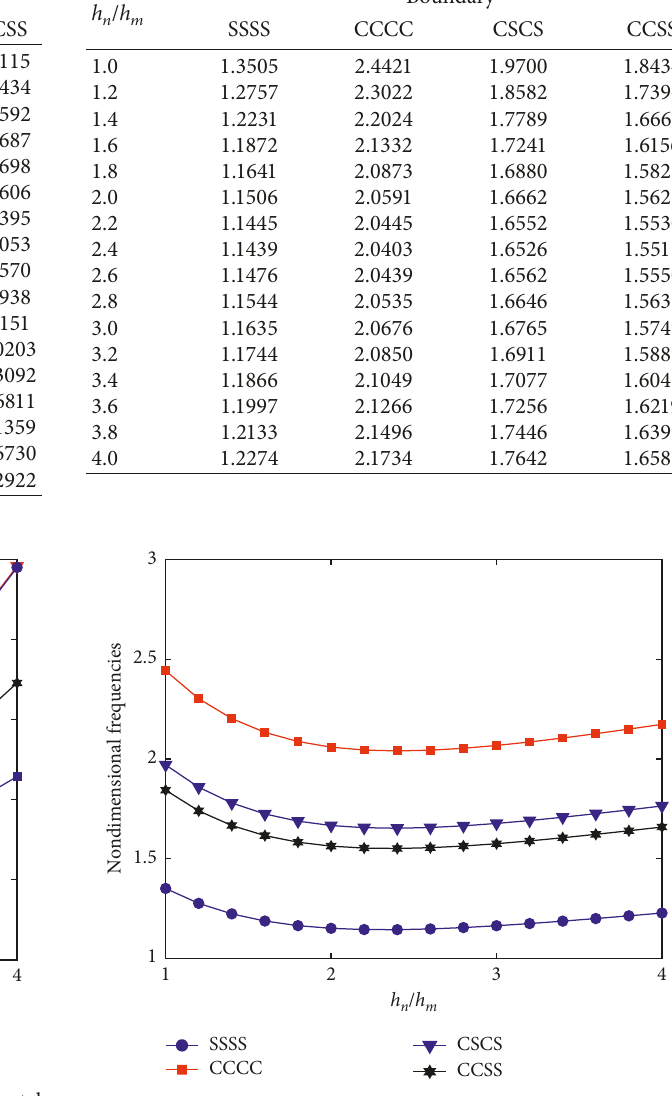
h n / m on nondimensional funda- / E m � st